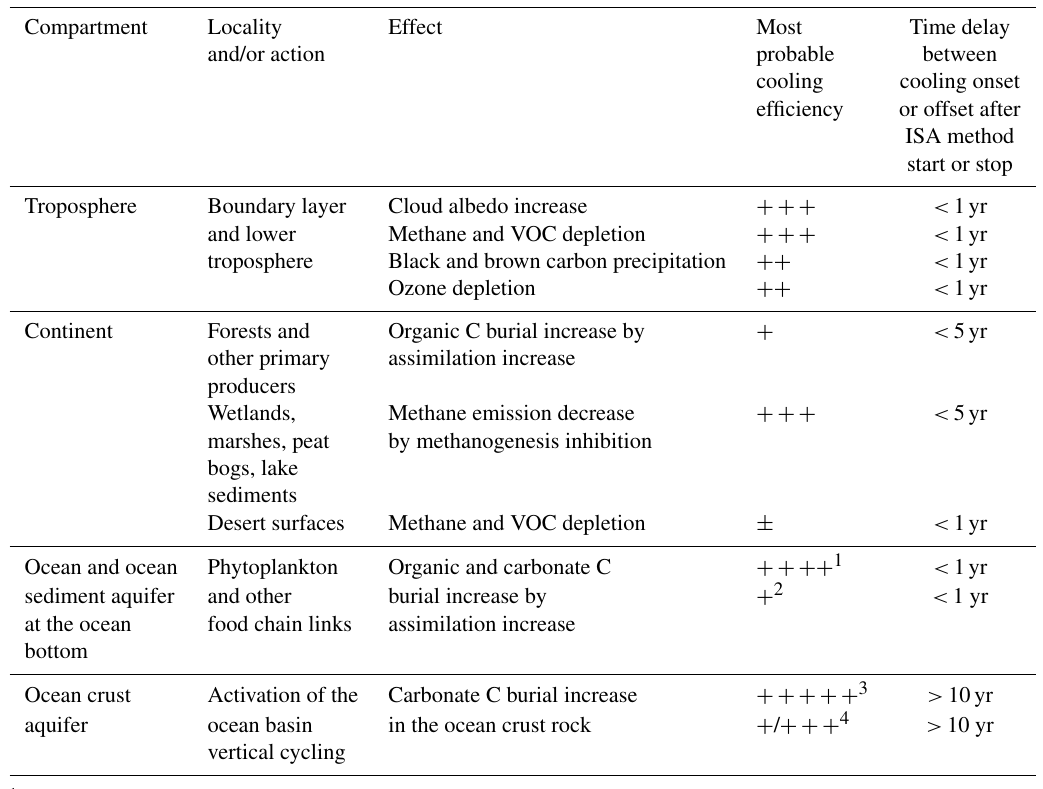
Table 3. Principal effects of the ISA method proposed – or its natural equivalent – and their probable consequences for the different biosphere